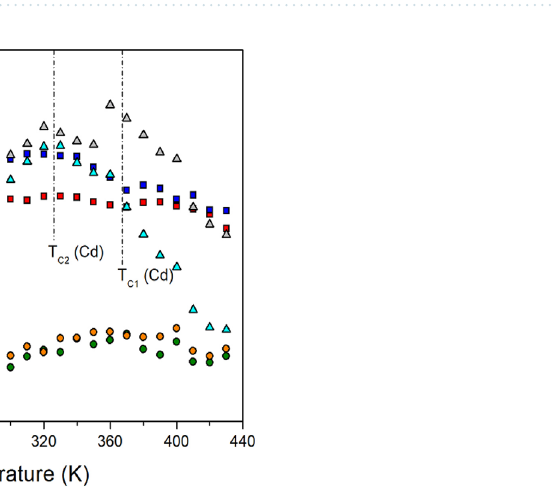
Figure 8. 1 H NMR spin–lattice relaxation times T 1ρ of [NH 3 (CH 2 ) 3 NH 3 ] Me Br 4 ( Me = Cu, Zn, and Cd) as a function of temperature.